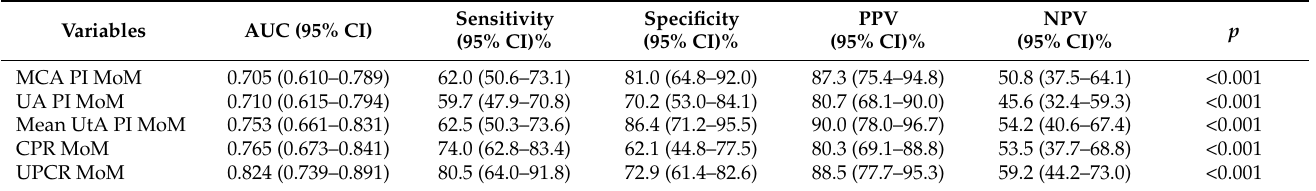
Table 4. Predictive performance of Doppler parameters for adverse perinatal outcome of late-onset FGR.